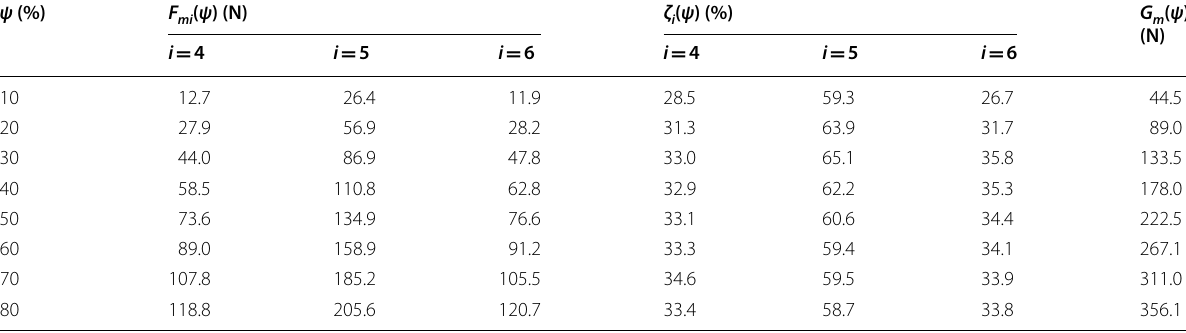
( ψ ), G ( ψ ) and ζ ( ψ ) in the case of different material filling mi m i